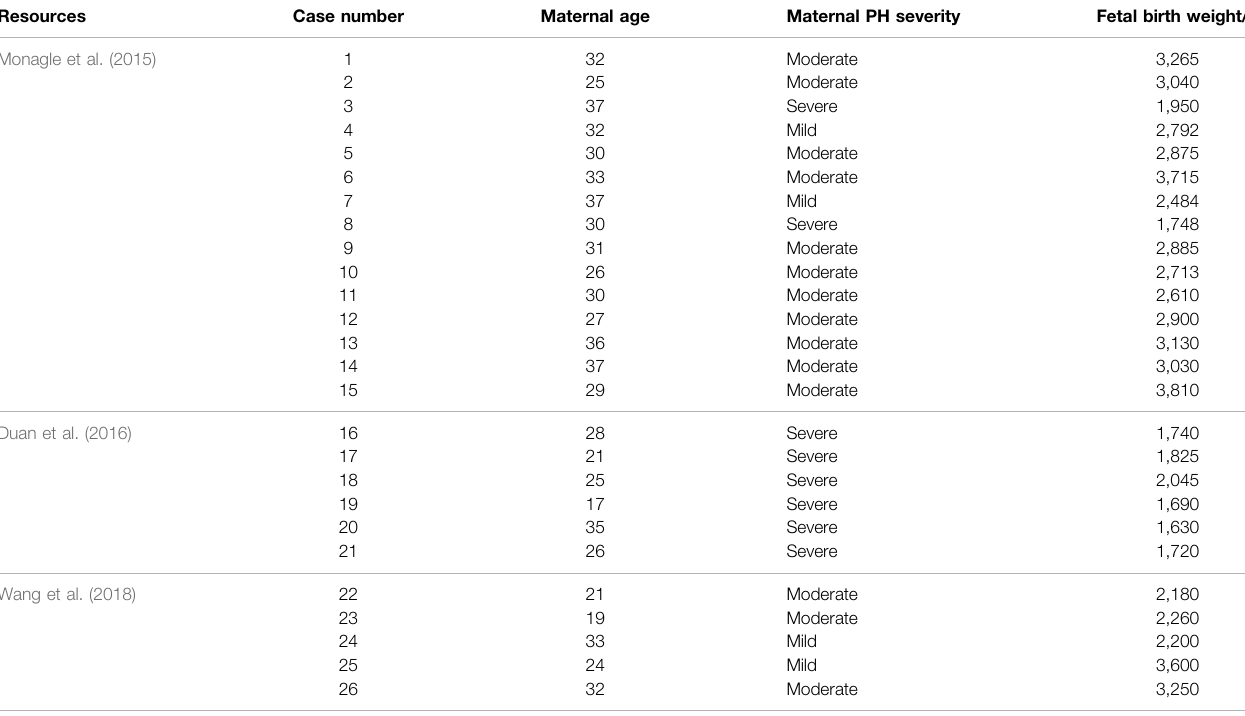
TABLE 2 | Included human maternal PH severity and fetal birth weight.